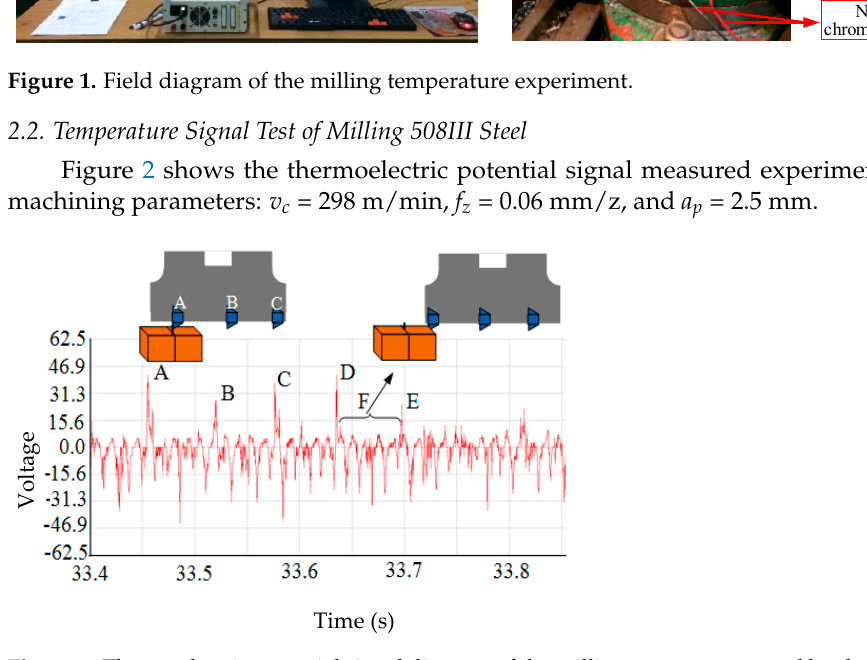
Figure 1. Field diagram of the milling temperature experiment.